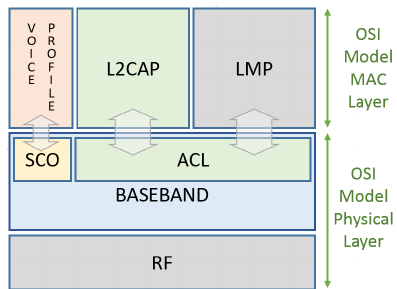
Figure 4. Mapping of OSI reference model to IEEE 802.15.1 Bluetooth